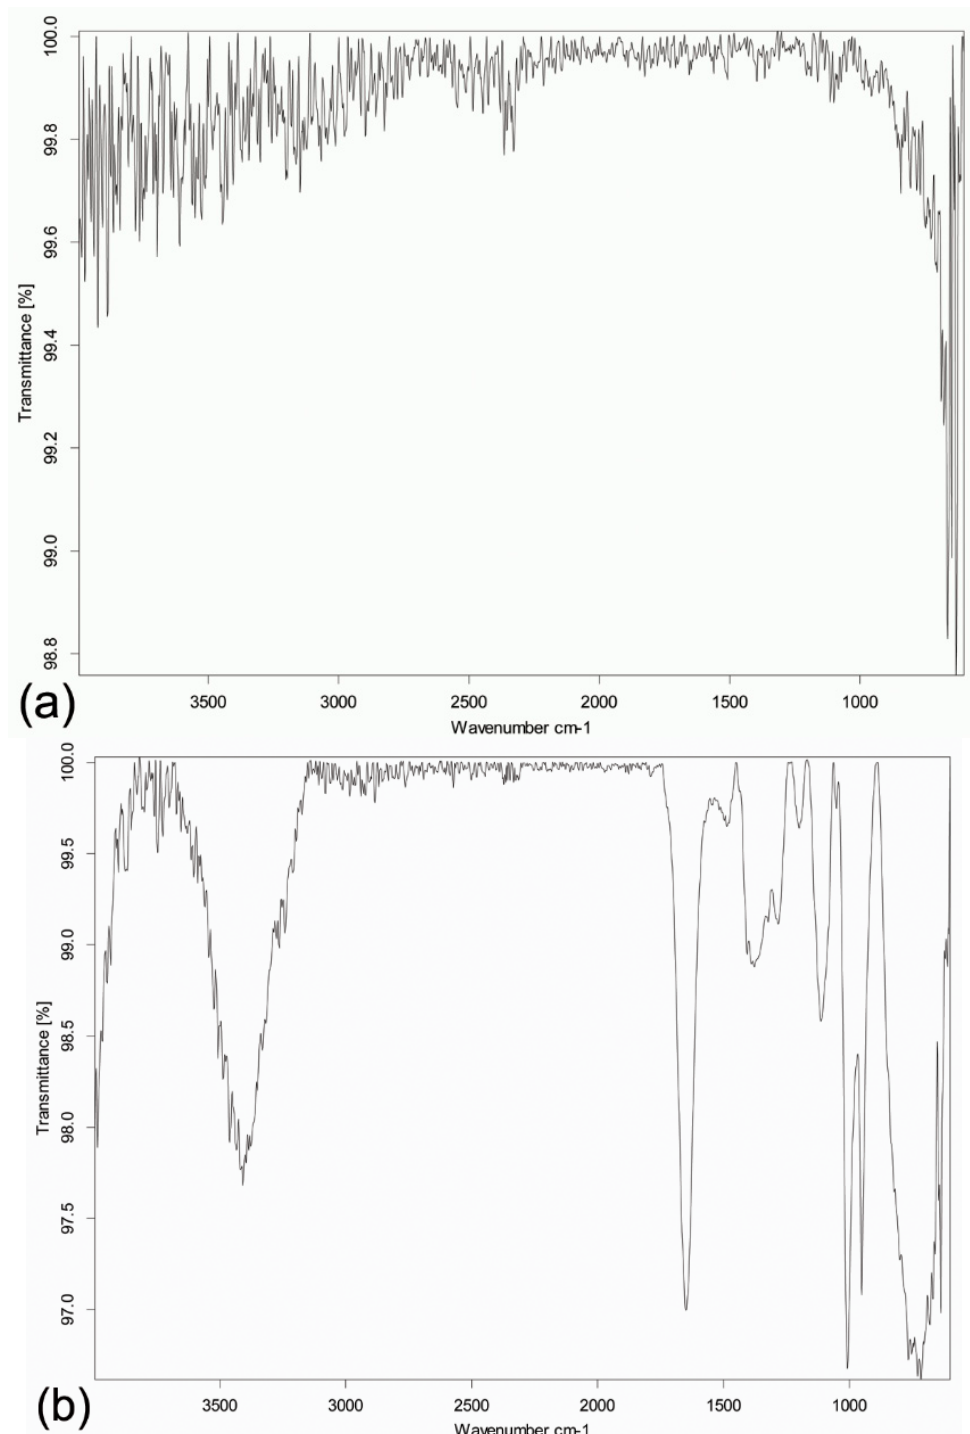
Figure 5. Representative Fourier-transformed infrared spectra of the titanium discs. ( a ) Spectrum of the sandblasted, large-grit, acid-etched surface-treated titanium disc. ( b ) Spectrum of the same kind of disc but further immersed in simvastatin solution. Note the distinct bands of the functional groups OH (3600–3200 cm − 1 ) and C=O (1800–1600 cm − 1 ), which are present on simvastatin. The characteristic fingerprint region of simvastatin occurring at <1500 cm − 1 further confirms alteration of the surface of the titanium disc upon simvastatin